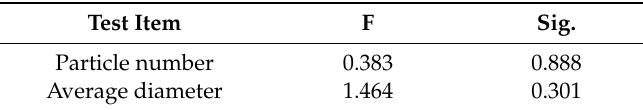
Table 7. Results of ANOVA test.